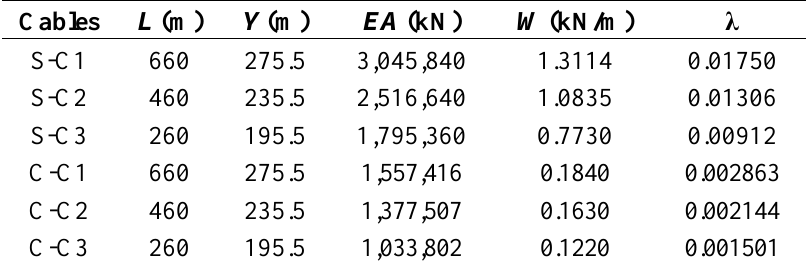
Table 5. Material properties of stay cables.